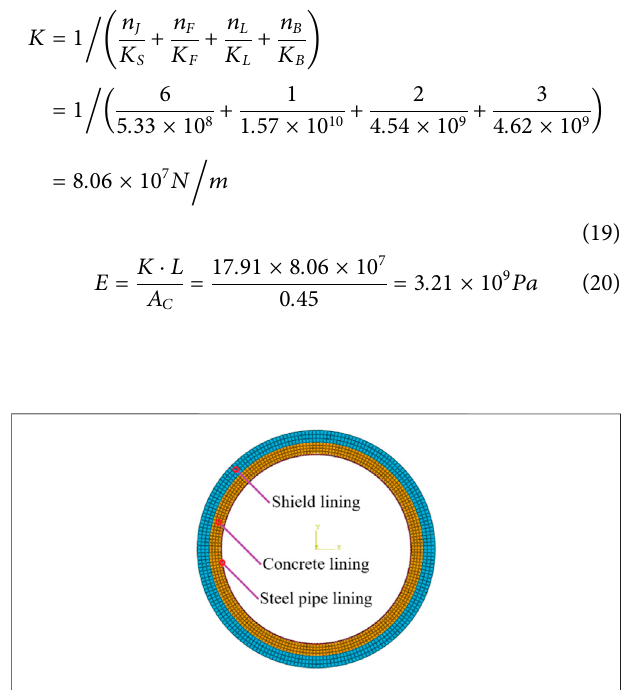
FIGURE 6 | Finite element calculation